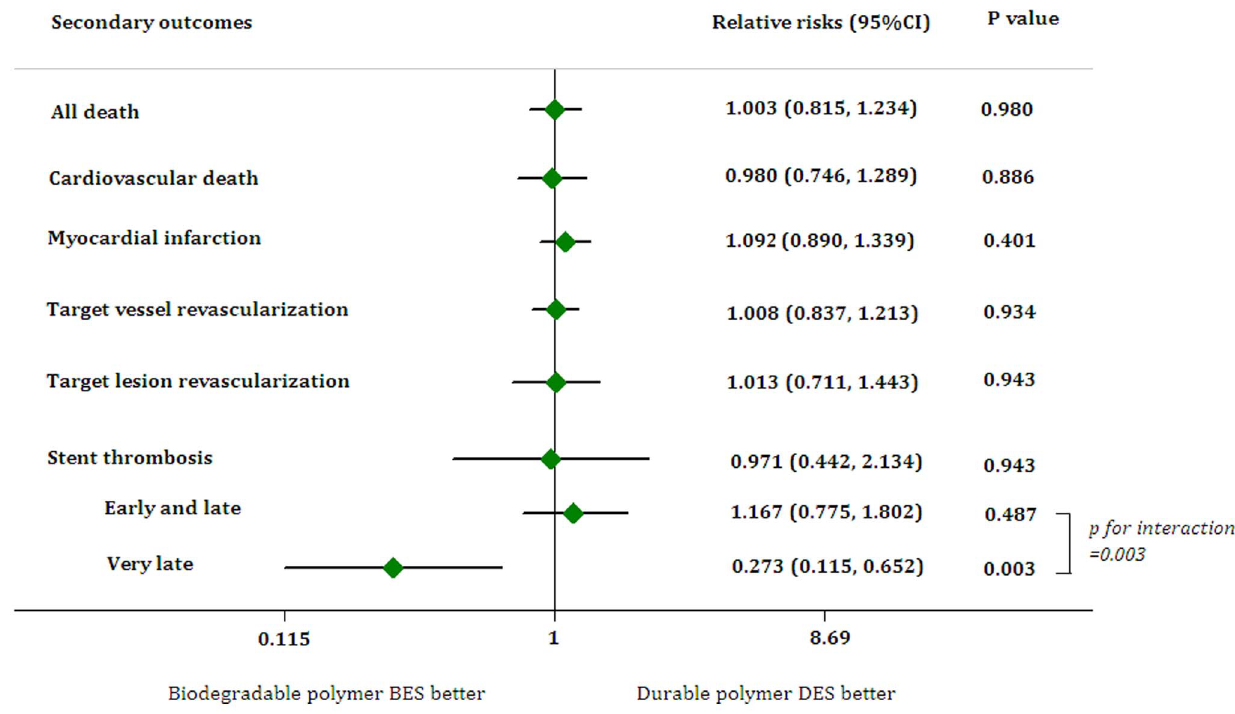
Figure 3. Forest plot for secondary outcomes associated with biodegradable polymer BES versus durable polymer DES. The squares and the horizontal lines indicate the relative risks, and the 95% confidence intervals for each secondary outcome. BES: biolimus-eluting stents; DES: drug-eluting stents.